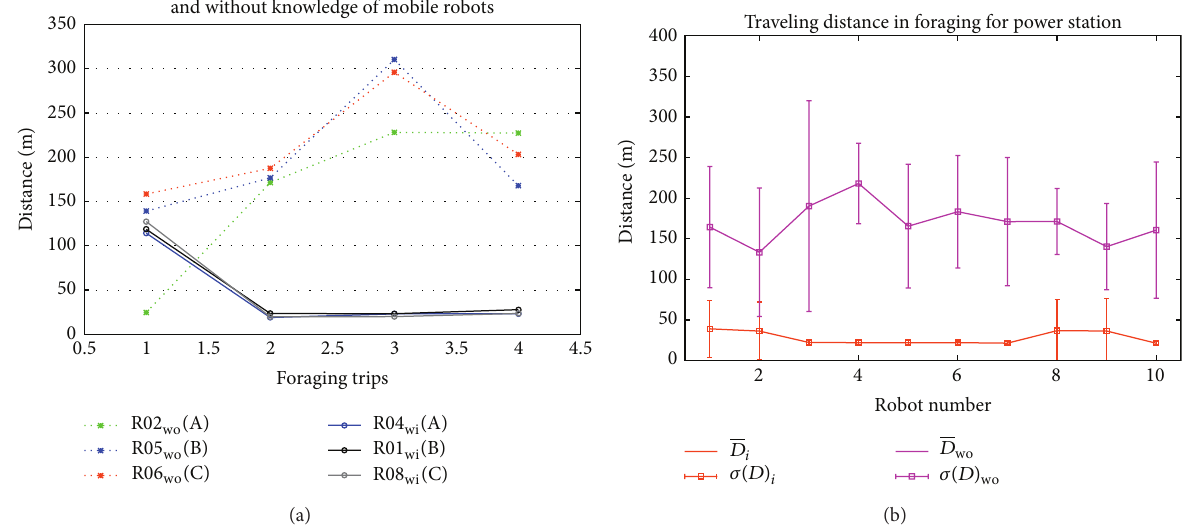
Figure 14: Traveling distance in foraging behavior with knowledge sharing and without knowledge sharing by (a) selected 3 mobile robots of each environment and (b) average and standard deviation of traveling distance in foraging for power